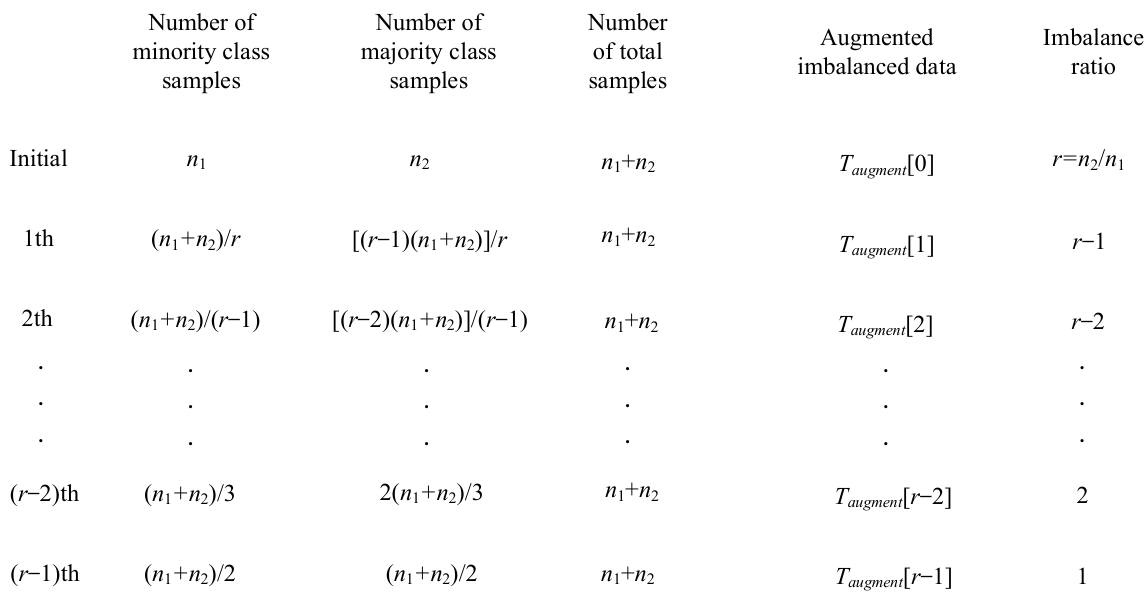
Table 1. Binary classification confusion